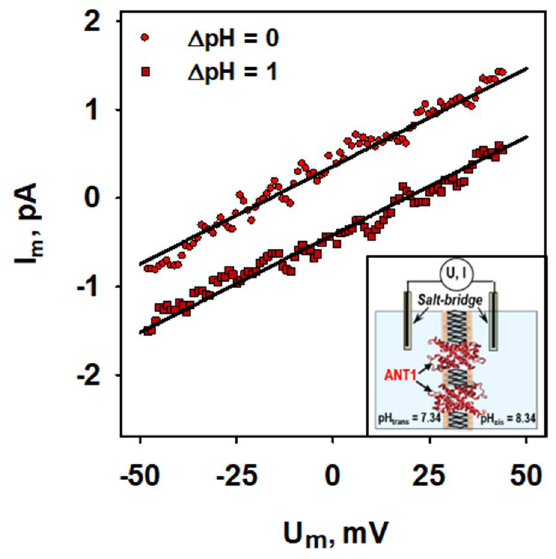
Figure 3. The proton turnover number of ANT is similar to UCPs. Representative current-voltage recordings of lipid bilayer membranes reconstituted with ANT1 in the presence (squares) and absence (circles) of ∆ pH = 1.0 across the membrane. Lines represent a linear fit to the data. Planar bilayer membranes were made of 45:45:10 mol % PC:PE:CL reconstituted with 15 mol % AA. Buffer contained 50 mM Na 2 SO 4 , 10 mM Tris, 10 mM MES and 0.6 mM EGTA at pH = 7.34 and T = 306 K. Lipid concentration was 1.5 mg/(mL of buffer solution). Protein concentration measured by transmembrane pH gradient.